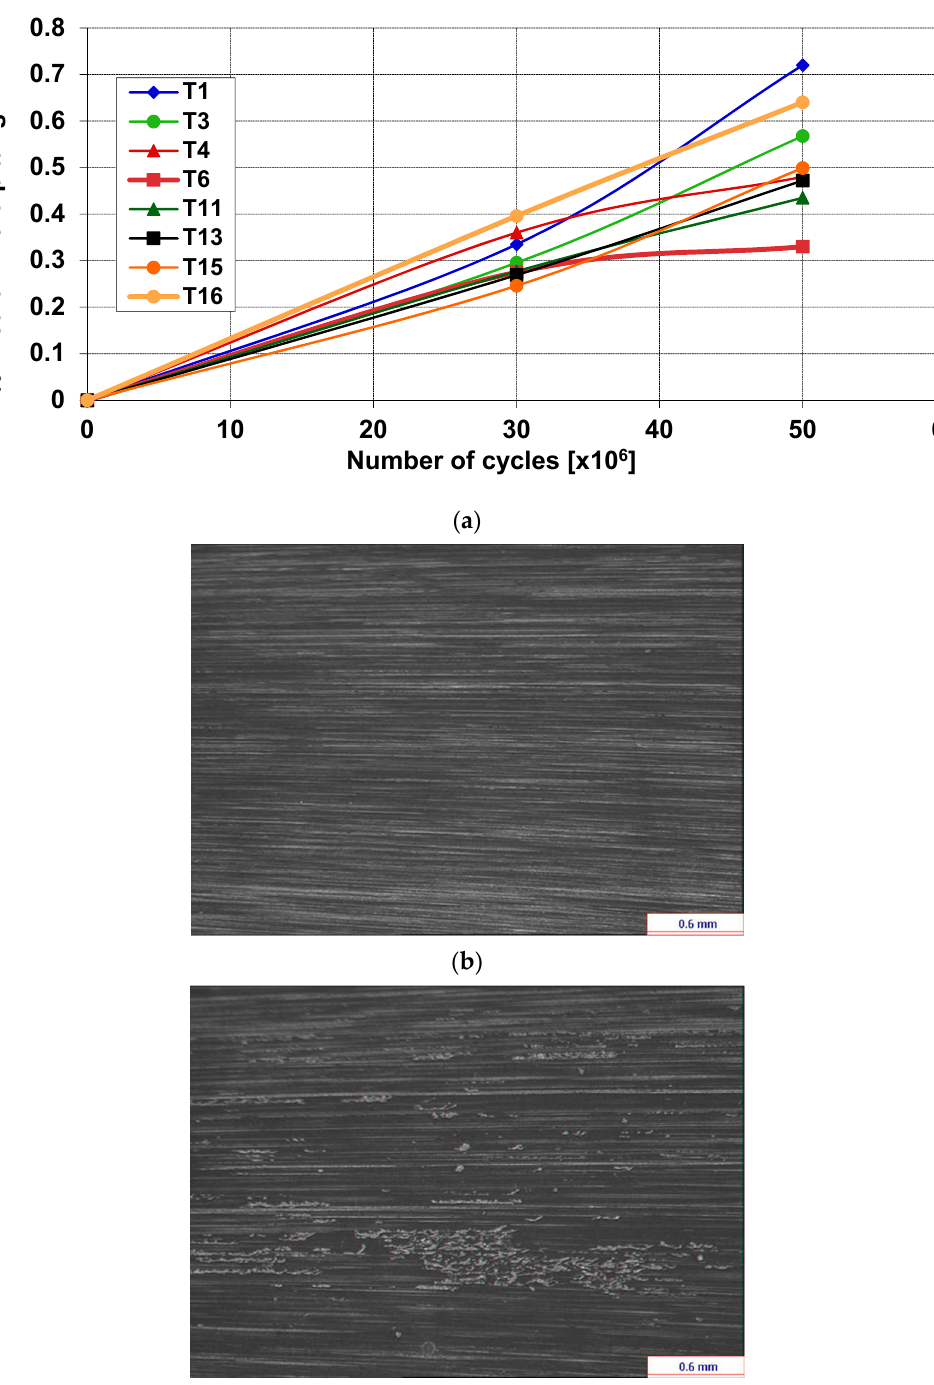
Figure 2. Results of stereo optical evaluation of gear tooth surfaces affected by a pitting ( a ); tooth surface conditions at the beginning ( b ) and at the end ( c ) of the experiment [59].